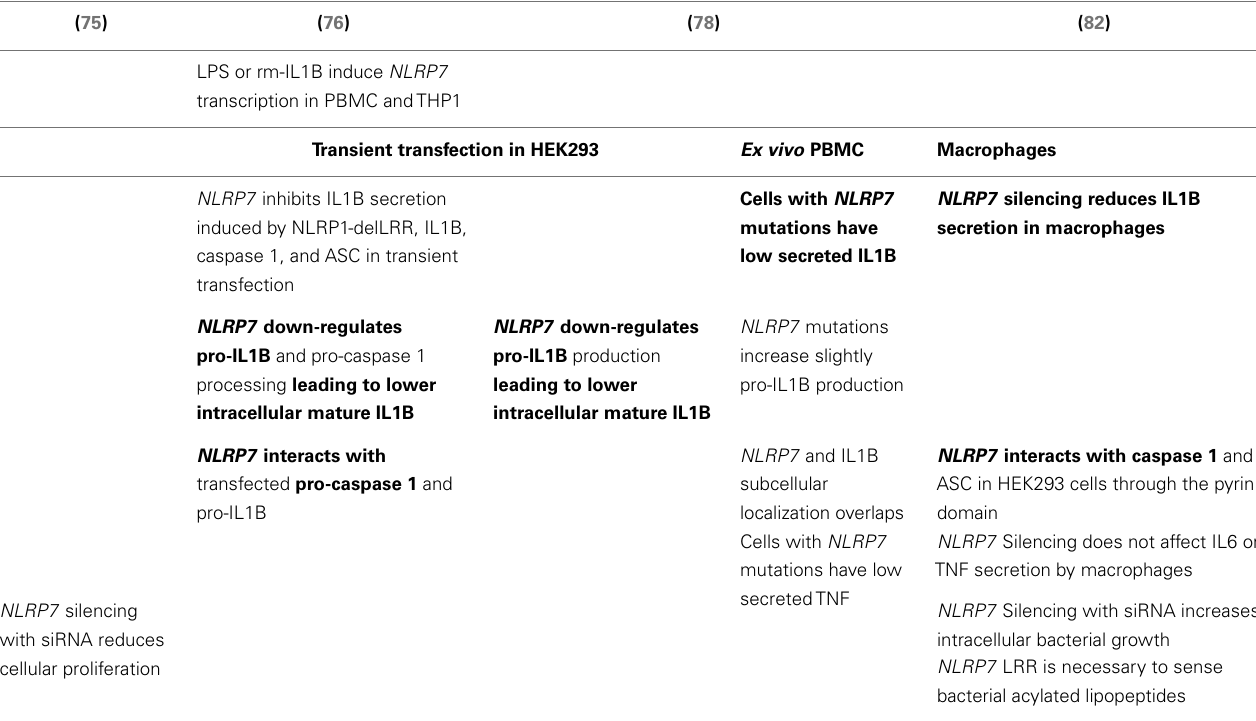
Table 1 | Recapitulation of the functional roles of NLRP7 in different studies and cellular models.